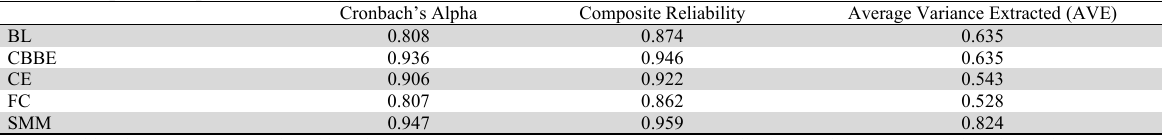
Cronbach alpha, composite reliability and AVE